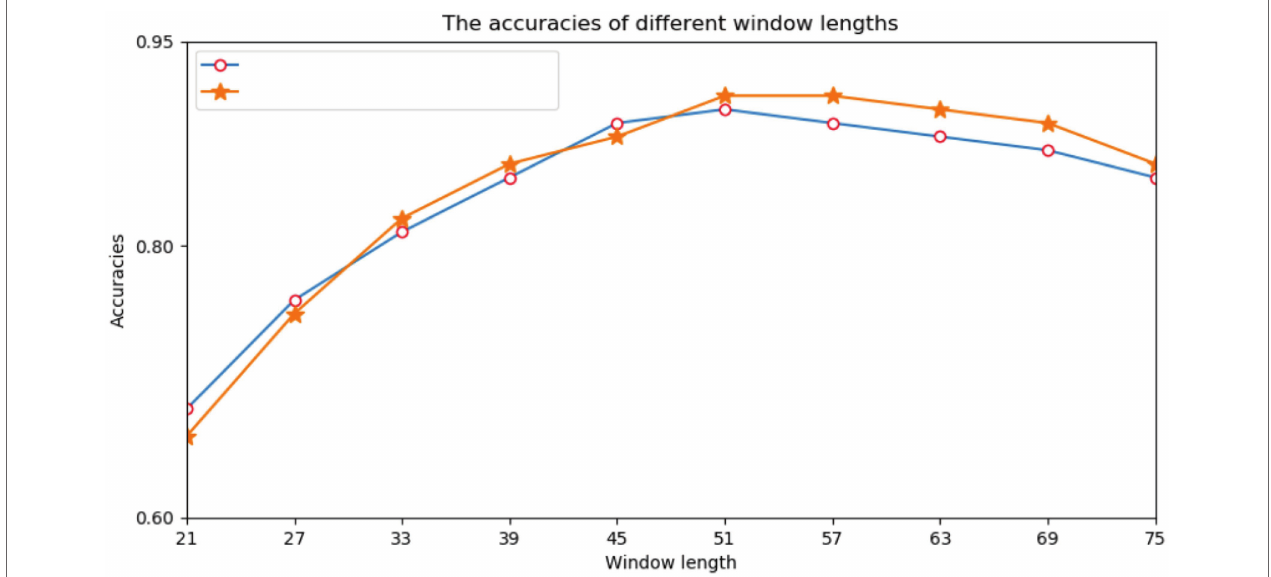
FIGURE 3 | Accuracy of the verification set for various window